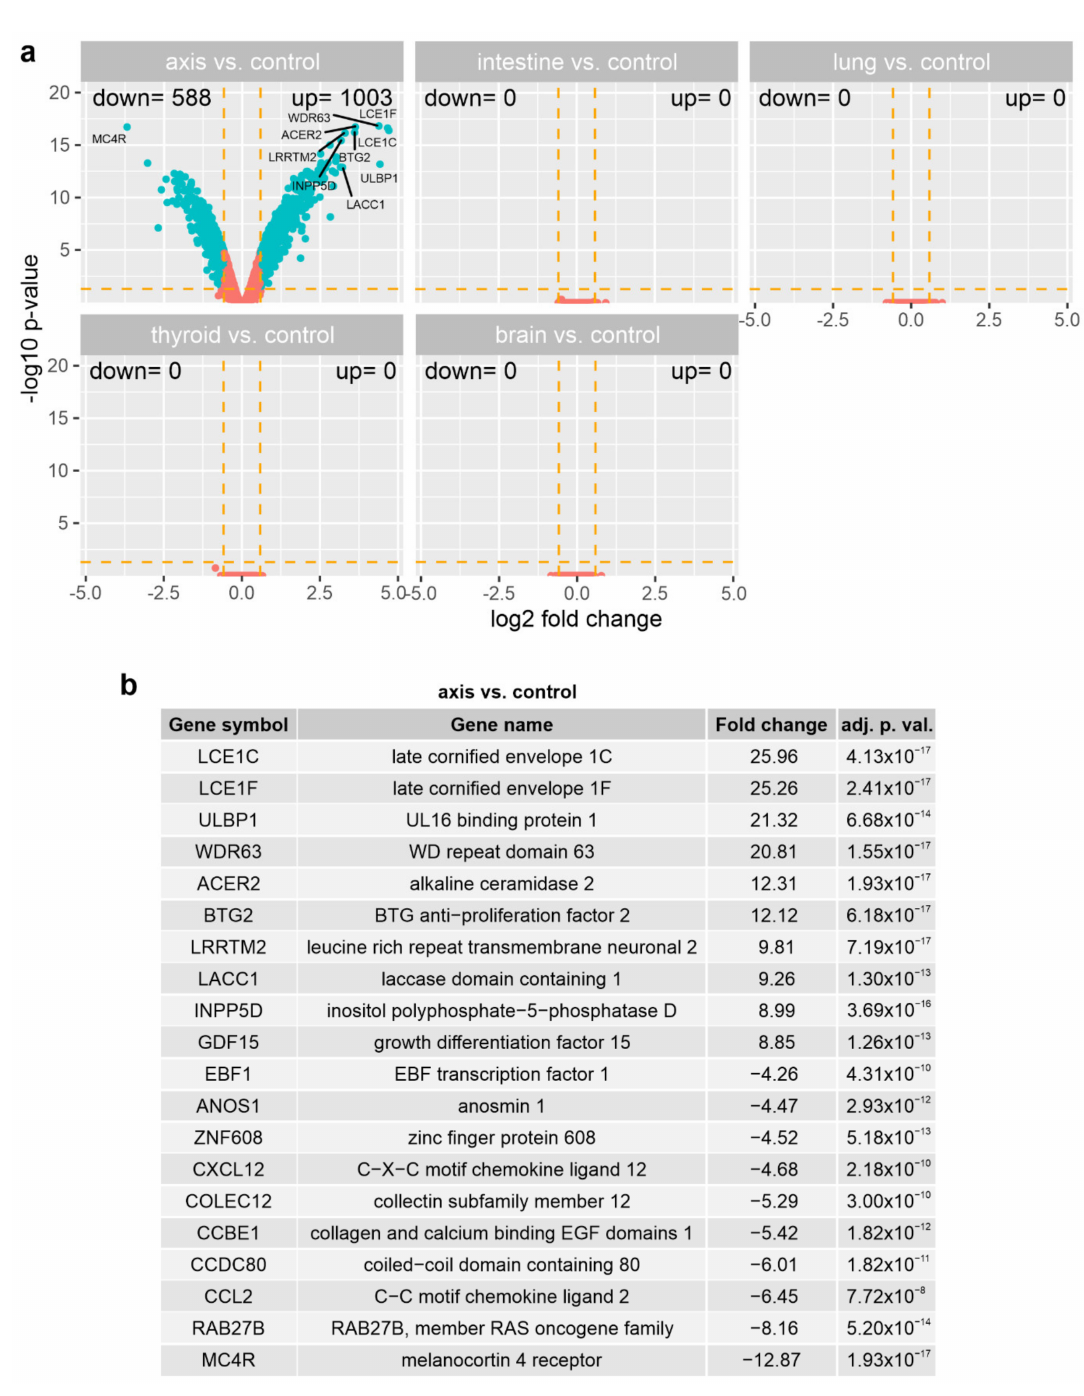
Figure 5. The transcriptomic profiles of prostate cells irradiated in the beam axis and peripheral organs. ( a ) Volcano plots depicting expression profiles of the experimental groups. Each dot represents the mean expression (three biological replicates) of an individual gene obtained from a normalised microarray dataset. The dotted orange lines (cut-off values) were established according to the following parameters: |fold change| = 1.5 and p value = 0.05. Genes above the cut-off lines were considered as differentially expressed genes and are shown as blue dots. The total numbers of up- and down-regulated genes are given in the top right and top left corners, respectively. The ten most differentially expressed genes are marked on the plot; ( b ) 20 genes with the highest (10 genes) and the lowest (10 genes) fold change from the list of genes differentially expressed between the cells irradiated in axis and